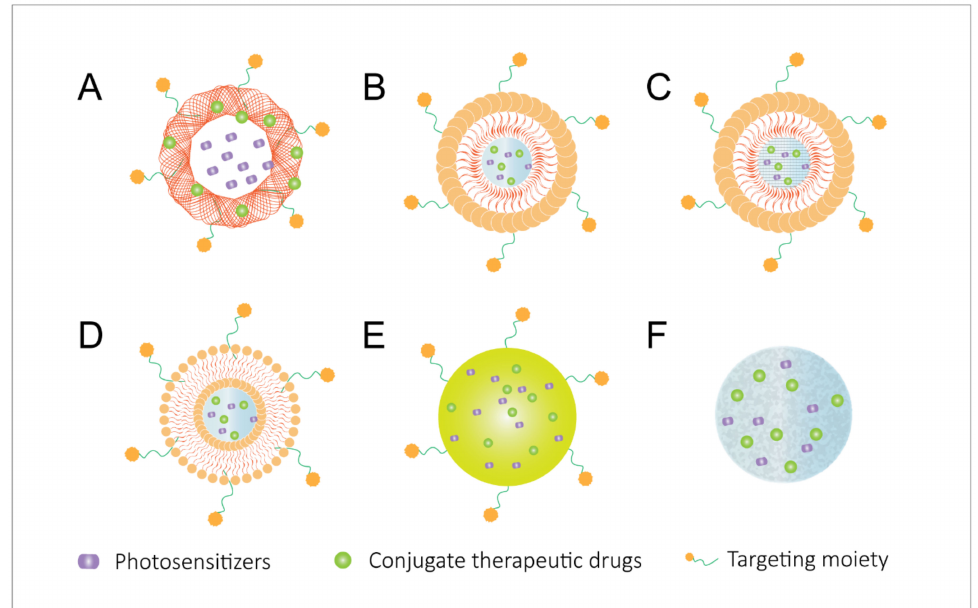
Figure 4. Most used codelivery systems for combined therapies with PDT in cancer, including ( A ) polymeric nanoparticles (PNPs), ( B ) nanostructured lipid carriers (NLCs), ( C ) solid lipid nanopar- ticles (SLNs), ( D ) liposomes, ( E ) gold nanoparticles (AuNPs), and ( F )